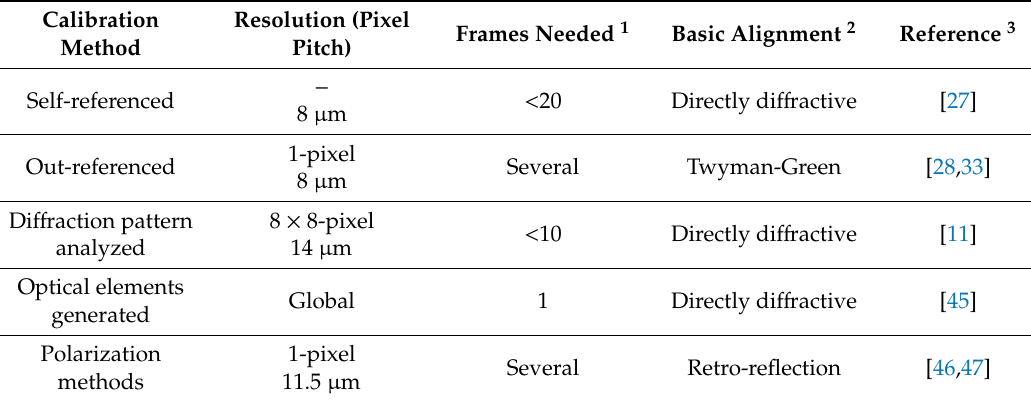
Table 1. Phase calibration methods with best spatial